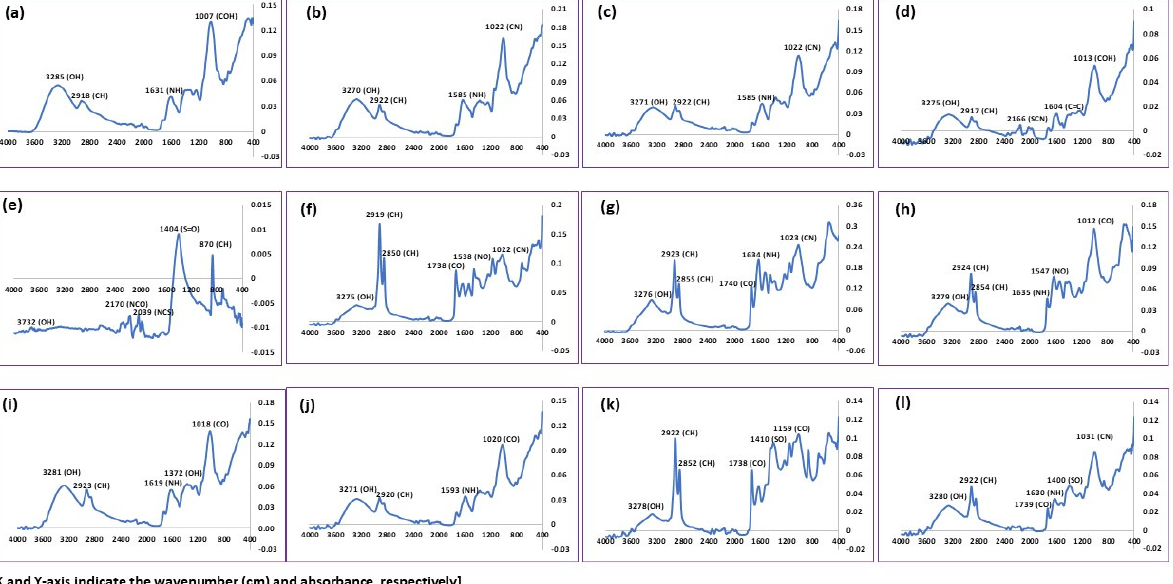
Figure 5. FTIR analysis of different non-edible food waste (( a ). brinjal waste, ( b ). potato peels, ( c ). banana peels, ( d ). orange peel, ( e ). eggshell, ( f ). cow bone, ( g ). chicken bone, ( h ). fish bone, ( i ). combined vegetable, ( j ). combined fruits, ( k ). combined animal, and ( l ). all combined).